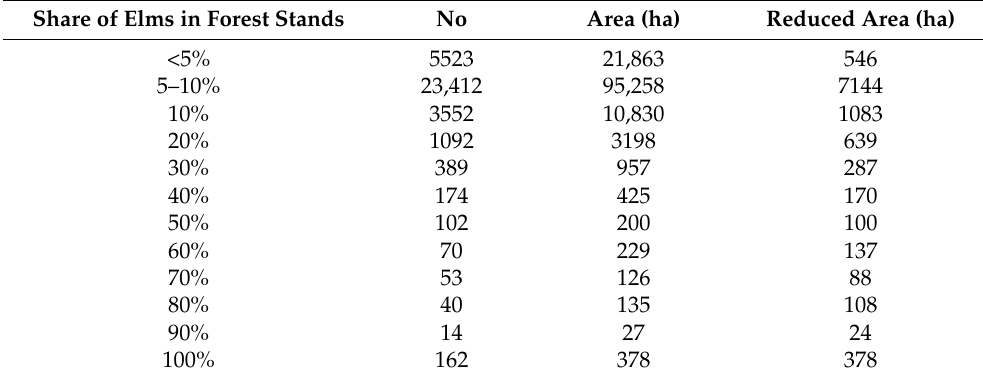
Table 2. Number and area of forest plots with elms in the study zone, with a subdivision into classes of their share in the forest stand.